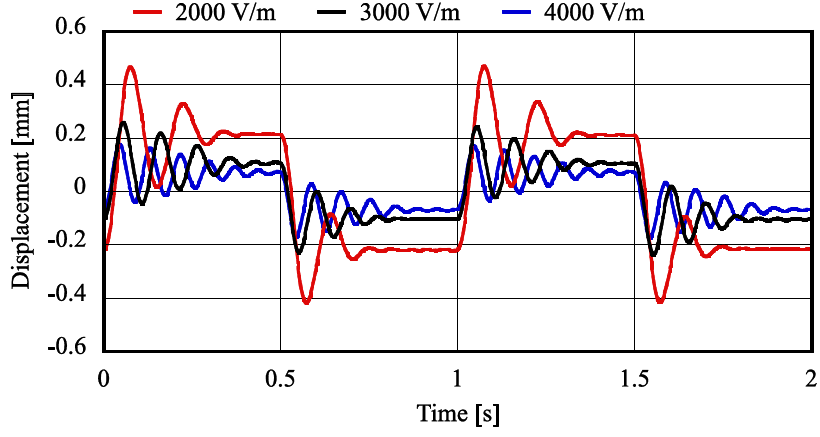
13 Figure 16. Comparison in time history in the steady state. FORE-controlled: blue line; PD-controlled: black line. The fluctuations in the steady-state suspension were almost the same in both suspension systems. The fluctuation and the vibration were due to the reset actions shown by Figure 12, and were expected to be smaller than the resolution of the sensor (5 μ m). Therefore, such a fluctuation and vibration were not visible in the experiment. 5.2. Responses to Rectangular Disturbance This subsection shows the responses to a rectangular disturbance. Figure 17shows the responses when the feedback gain p f was 2000, 3000, or 4000 V/m. Figure 18 shows the responses when the cutoff angular frequency α was 2000, 500, or 200 rad/s. The effects of increasing gain in p f or α were almost the same as in the simulation results shown in Section 4. However, the actual responses were more oscillatory than the simulations. The steady-state position varied depending on the cutoff